Question: Provide a one-line summary of what is displayed.
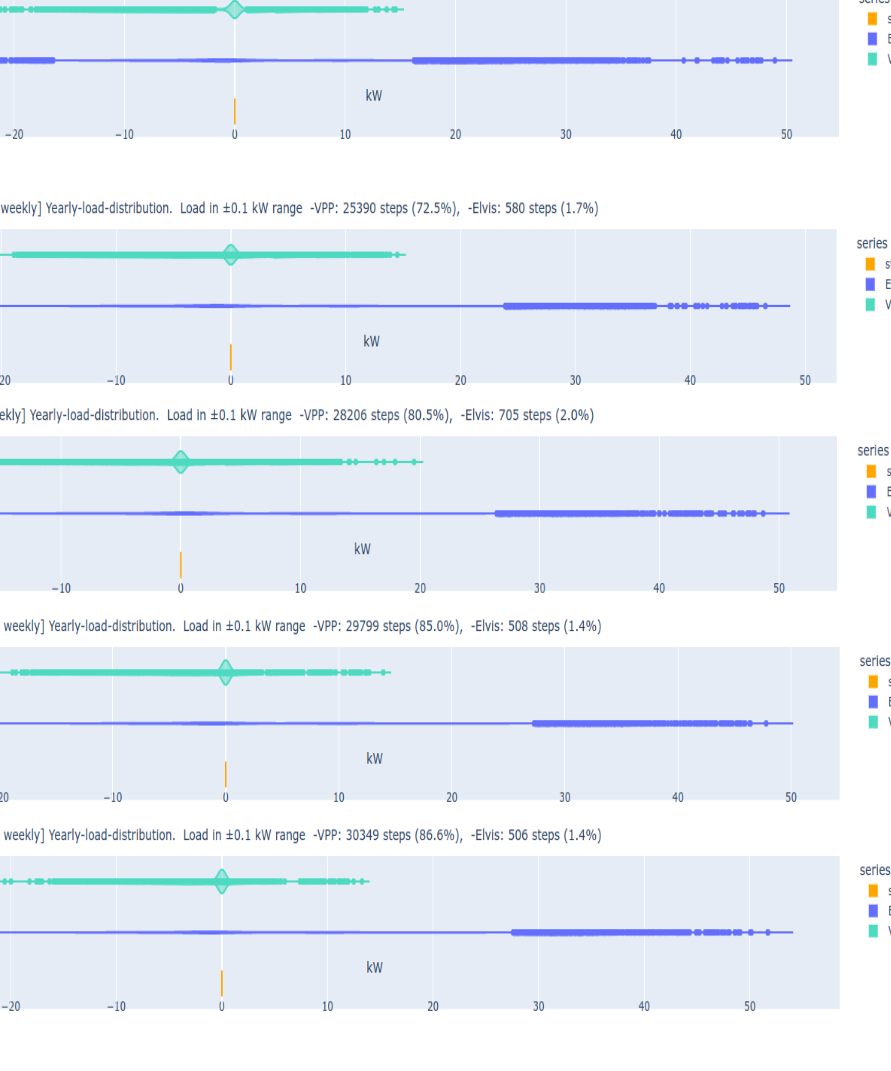
Answer: 4 describes better the decreasing trend along the axis: the difference between the coordinates of the clusters seems to decrease as the number of EVs arrivals rises. In other words, the clusters of results for 35 and 30 EVs arrivals